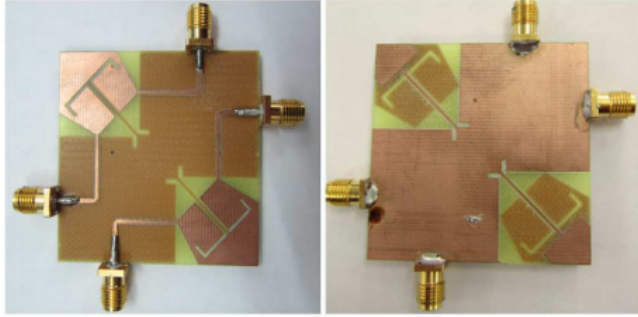
Figure 14. Compact co-radiator with dual polarization [76].